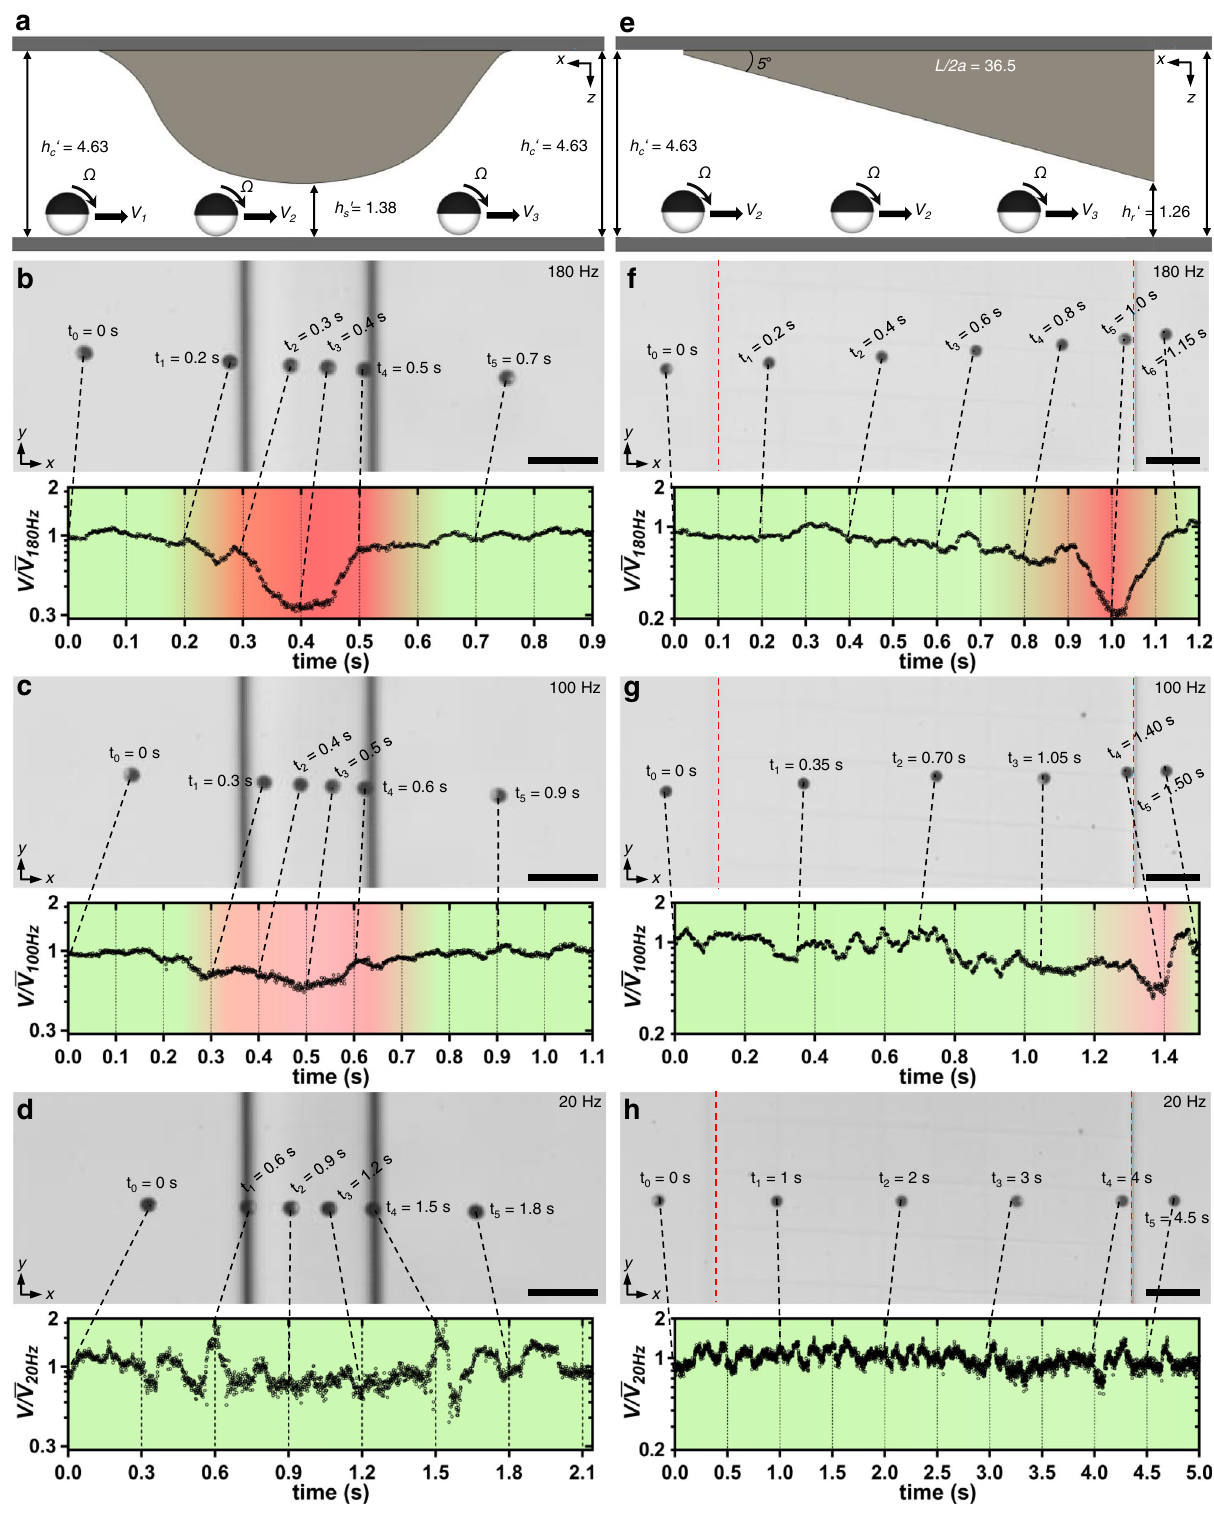
con fi nement changes non-linearly in the axis of the microroller translation direction, at each position underneath the half-sphere top wall, the con fi nement at the back and front of the microroller would be different, resulting in the velocity mismatch with the continuous con fi nement, shown Fig.